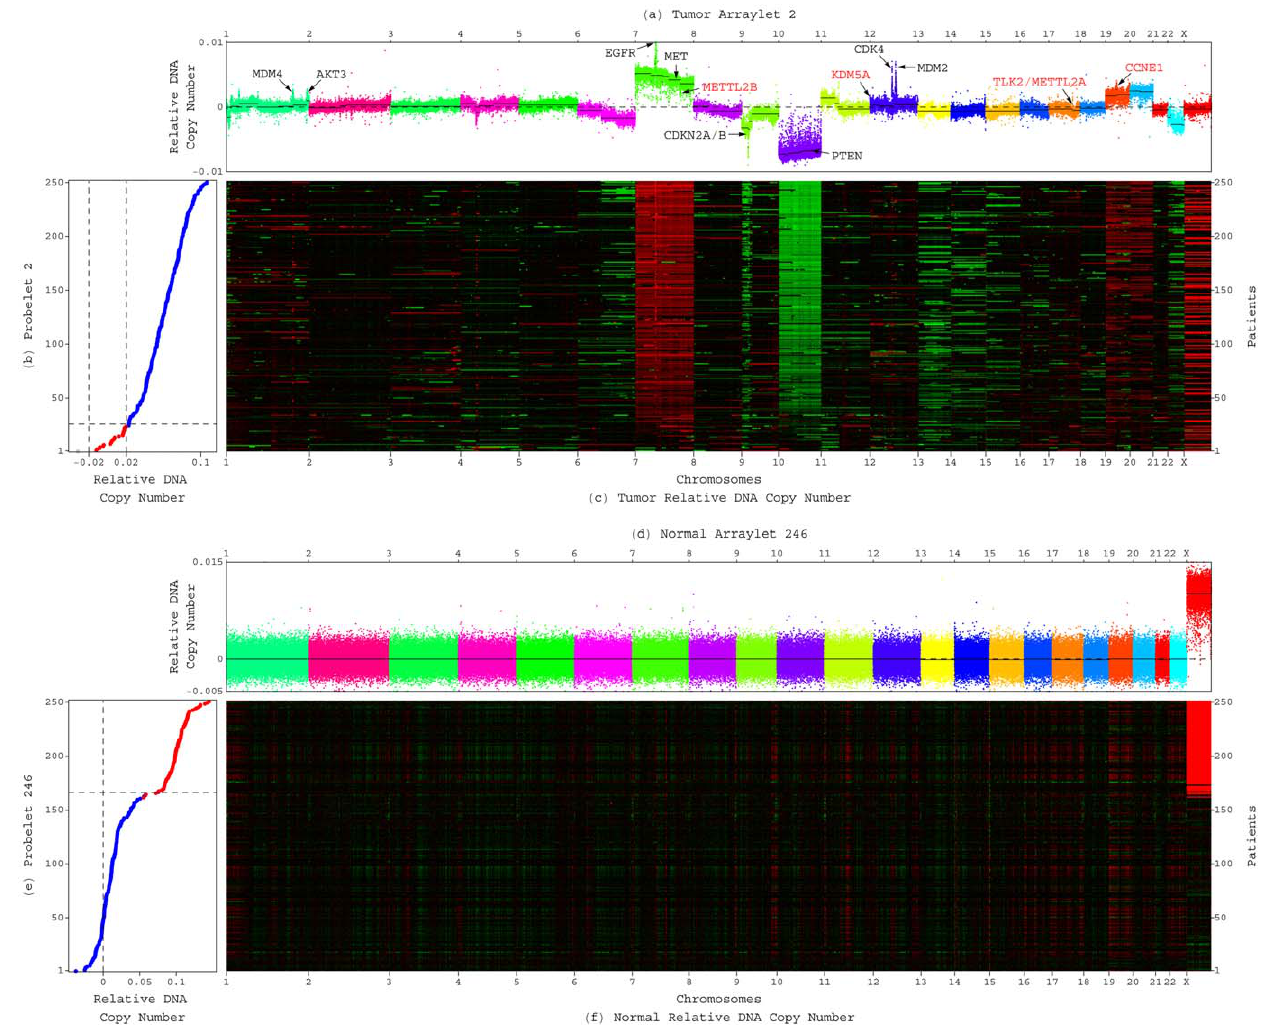
Figure 2. Significant probelets and corresponding tumor and normal arraylets uncovered by GSVD of the patient-matched GBM and normal aCGH profiles. ( a ) Plot of the second tumor arraylet describes a global pattern of tumor-exclusive co-occurring CNAs across the tumor probes. The probes are ordered, and their copy numbers are colored, according to each probe’s chromosomal location. Segments (black lines) identified by circular binary segmentation (CBS) [20,21] include most known GBM-associated focal CNAs (black), e.g., EGFR amplification. CNAs previously unrecognized in GBM (red) include an amplification of a segment containing the biochemically putative drug target-encoding TLK2 . ( b ) Plot of the second most tumor-exclusive probelet, which is also the most significant probelet in the tumor dataset (Figure S1 a in Appendix S1), describes the corresponding variation across the patients. The patients are ordered and classified according to each patient’s relative copy number in this probelet. There are 227 patients (blue) with high ( w 0.02) and 23 patients (red) with low, approximately zero, numbers in the second probelet. One patient (gray) remains unclassified with a large negative ( v 2 0.02) number. This classification significantly correlates with GBM survival times (Figure 3 a and Table S1 in Appendix S1). ( c ) Raster display of the tumor dataset, with relative gain (red), no change (black) and loss (green) of DNA copy numbers, shows the correspondence between the GBM profiles and the second probelet and tumor arraylet. Chromosome 7 gain and losses of chromosomes 9p and 10, which are dominant in the second tumor arraylet (Figure 2 a ), are negligible in the patients with low copy numbers in the second probelet, but distinct in the remaining patients (Figure 2 b ). This illustrates that the copy numbers listed in the second probelet correspond to the weights of the second tumor arraylet in the GBM profiles of the patients. ( d ) Plot of the 246th normal arraylet describes an X chromosome- exclusive amplification across the normal probes. ( e ) Plot of the 246th probelet, which is approximately common to both the normal and tumor datasets, and is the second most significant in the normal dataset (Figure S1 b in Appendix S1), describes the corresponding copy-number amplification in the female (red) relative to the male (blue) patients. Classification of the patients by the 246th probelet agrees with the copy-number gender assignments (Table 1 and Figure S9 in Appendix S1), also for three patients with missing TCGA gender annotations and three additional patients with conflicting TCGA annotations and copy-number gender assignments. ( f ) Raster display of the normal dataset shows the correspondence between the normal profiles and the 246th probelet and normal arraylet. X chromosome amplification, which is dominant in the 246th normal arraylet (Figure 2 d ), is distinct in the female but nonexisting in the male patients (Figure 2 e ). Note also that although the tumor samples exhibit female-specific X chromosome amplification (Figure 2 c ), the second tumor arraylet (Figure 2 a ) exhibits an unsegmented X chromosome copy- number distribution, that is approximately centered at zero with a relatively small width.